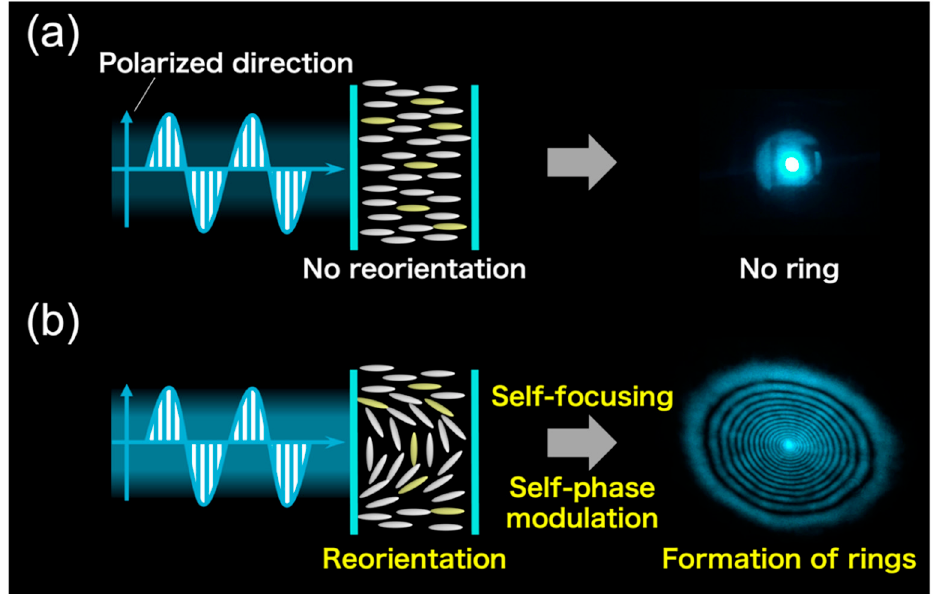
Figure 3. Principle of self-diffraction ring formation: ( a ) below and ( b ) above the threshold light intensity.